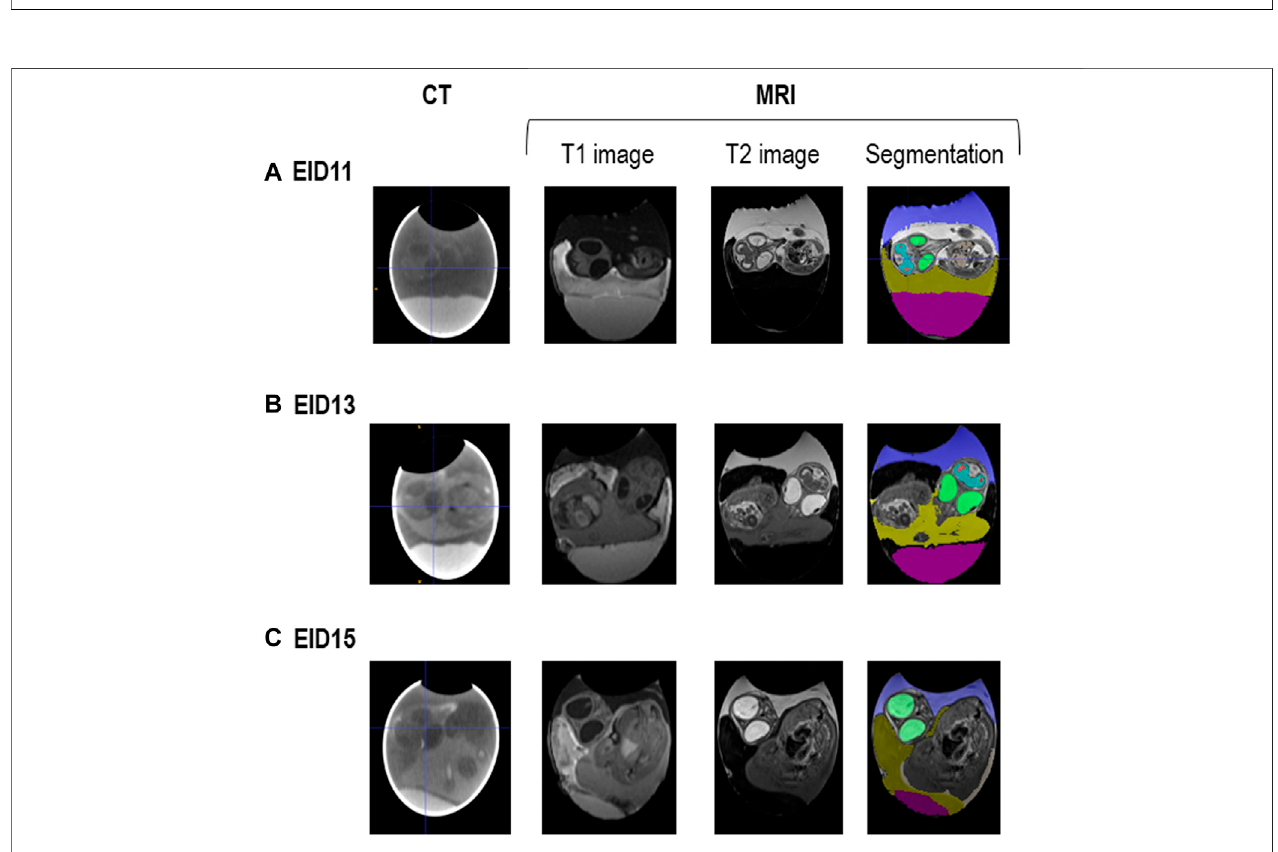
FIGURE6| CTandMRIrepresentativeimagesoffertilisedeggsduringincubation. (A) .After11daysofincubation(EID11). (B) .After13 daysofincubation(EID13). (C) . After 15 days of incubation (EID15). For segmentation (right panel), colours are as follows: in green, eyes; in blue and red spots, brain; in dark blue/purple, allantoic fl uid;inpink,eggwhite;inyellowishcolour,yolk.Theamniotic fl uidcorrespondstothewhitezonebetweentheembryoandtheallantoic fl uidonA(EID11,rightpanel)and to the dark zone between the embryo and the allantoic fl uid on B (EID13, right panel). The change in the MRI contrast of the amniotic fl uid between EID11 and EID13/EID15 (white to black), is due to the transfer of egg white into the amniotic cavity from EID12 onwards.